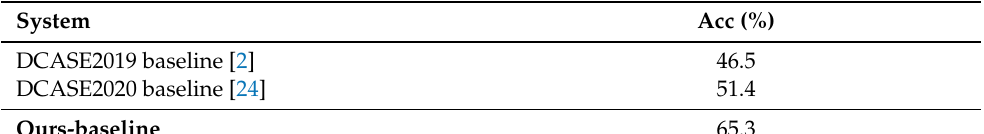
Table 2. Baseline comparison with other systems. Classification accuracies reported using DCASE2020 fold1 configuration.